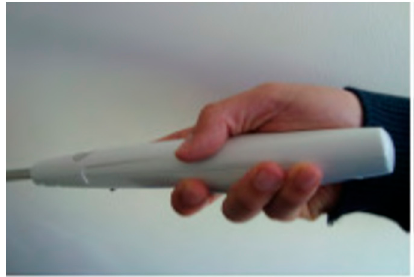
Figure 16. The prototype of grip [35].